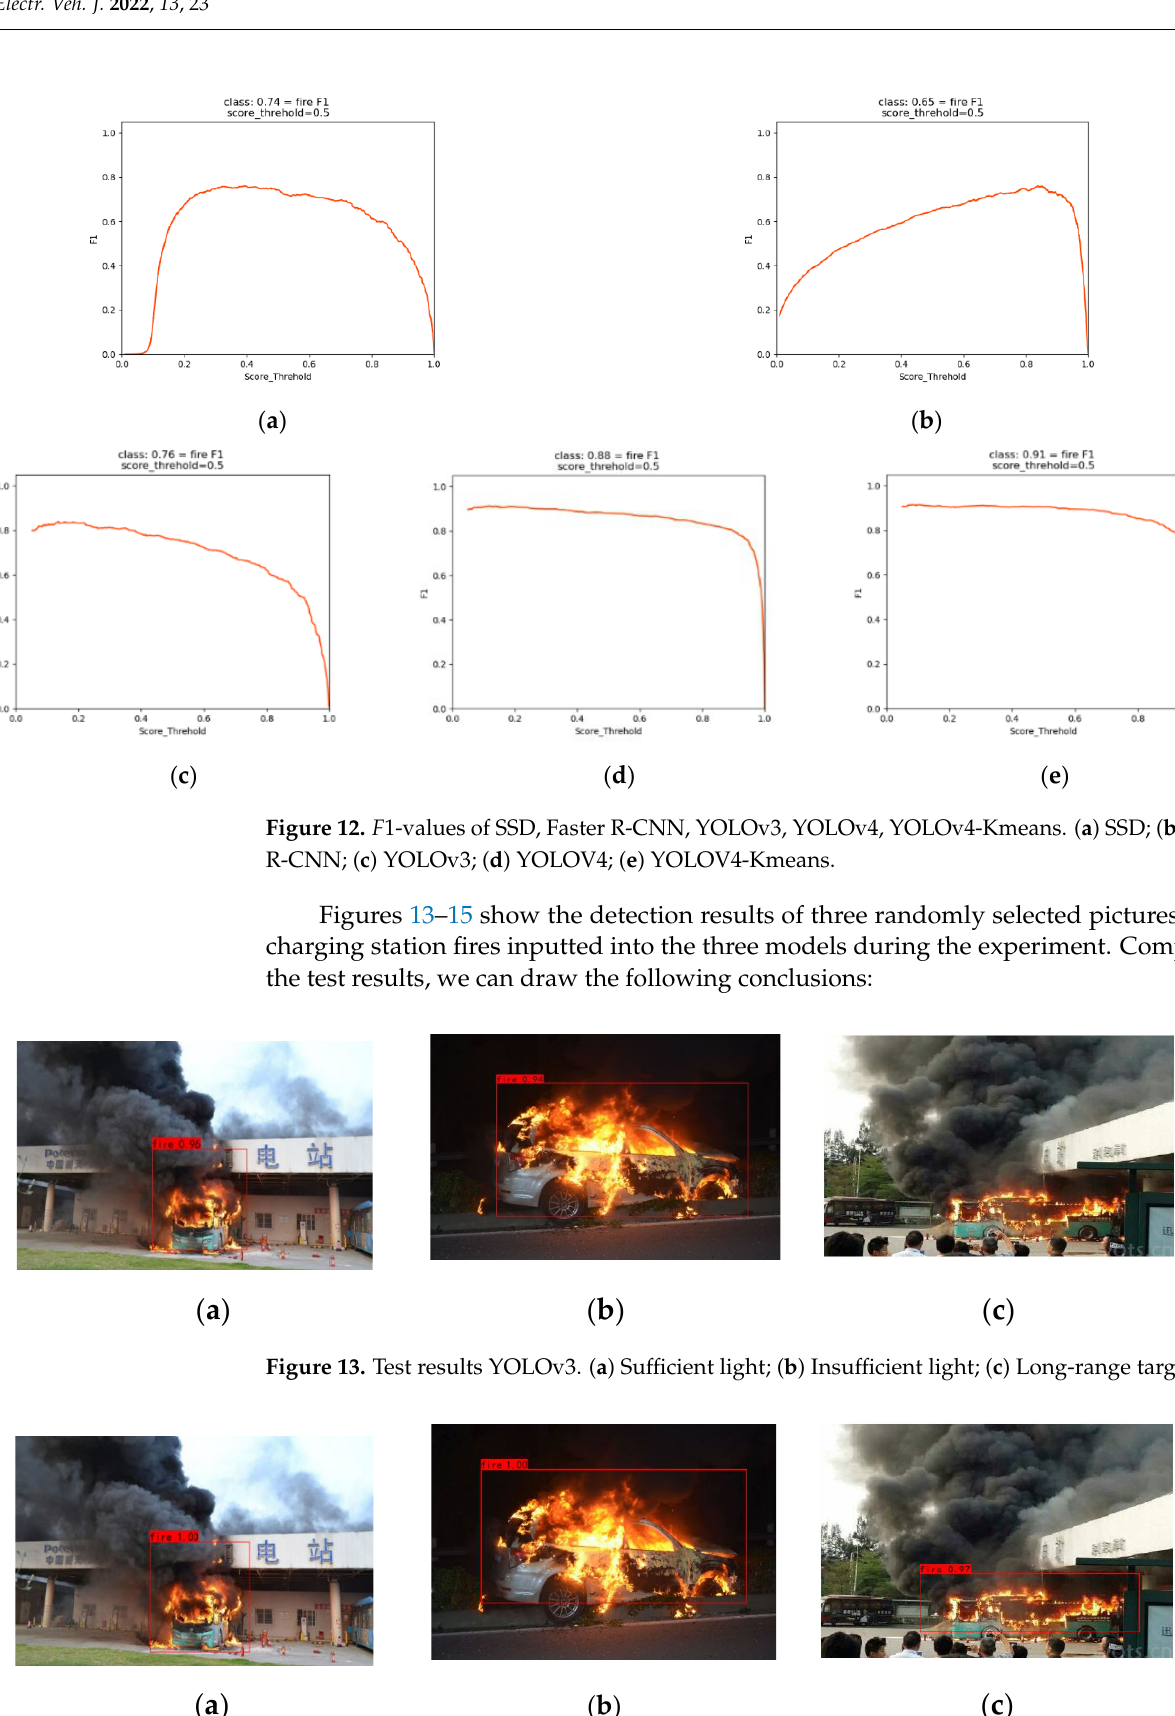
Figure 14. Test results of YOLOv4. ( a ) Sufficient light; ( b ) Insufficient light; ( c ) Long-range target.